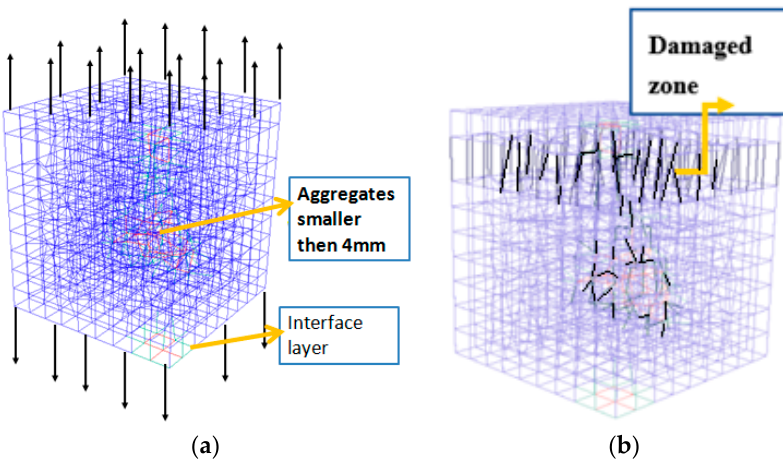
Figure 11. ( a ) Uniaxial tension test on the mortar-a4 scale (mortar-s in blue, aggregate particles in red, and interface layer in turquoise); and ( b ) the resulting damaged zone for the uniaxial tension simulation (damaged elements in black).